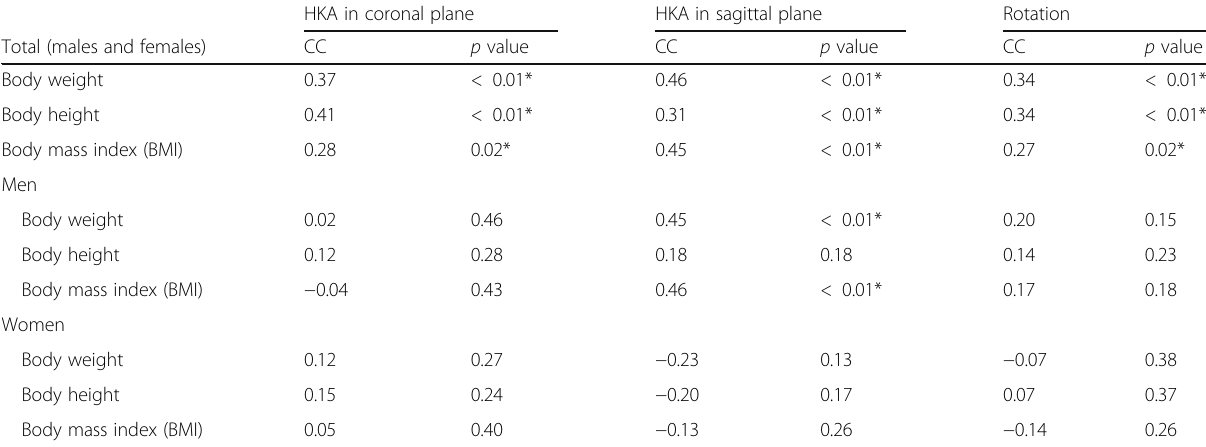
Table 2 Correlation between body constitution and